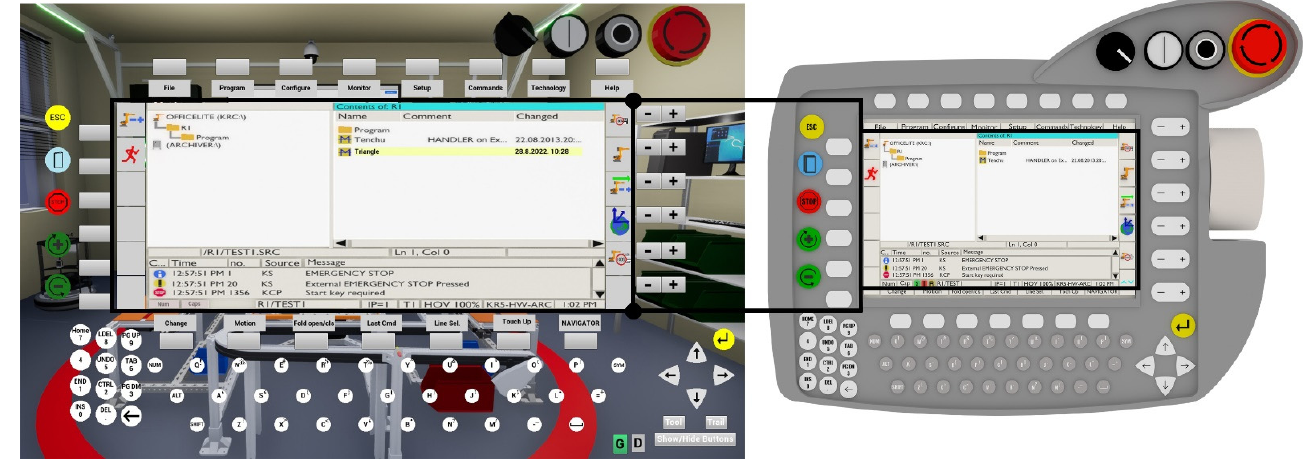
Figure 10. The user interface of the digital twin compared to the teach pendant.